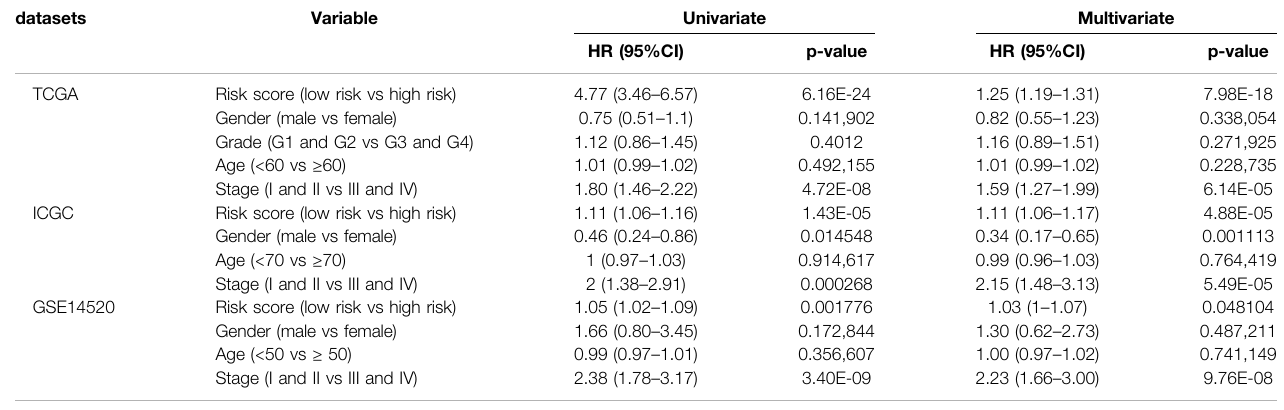
TABLE 2 | Univariate and multivariate analyses of prognostic factors in terms of OS. datasets